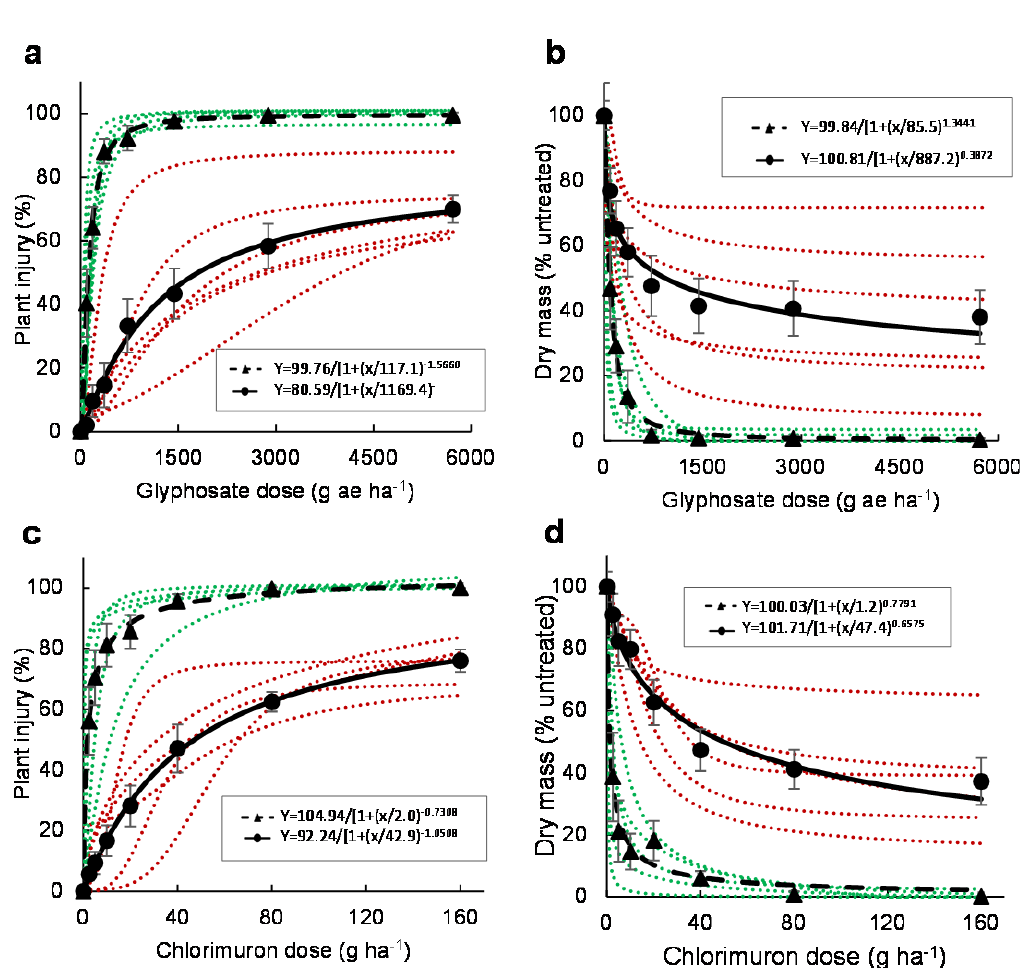
Figure 1. Glyphosate and chlorimuron-ethyl dose-response curves based on plant injury (%) and dry mass (% untreated) for 6 resistant ( ) and 6 susceptible ( ) Conyza populations from five Brazilian states. The non-linear regression model was adjusted (y = a / [1+(x / c) b ]) for resistant mean ( ) or susceptible mean ( ). Confidence interval: 95%